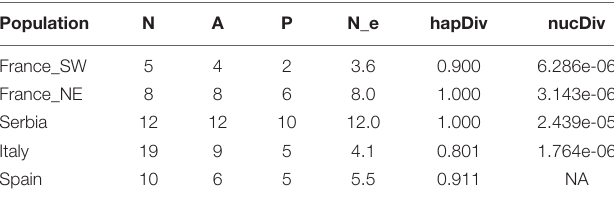
TABLE 2 | Sample size in each population (N), number of haplotypes detected in each population (A), number of private haplotypes (P), effective number of haplotypes (N_e), and genetic diversity suggested by Nei (1987) corrected for sample size (hapDiv) and nucleotide diversity (nucDiv) in chloroplast DNA sequences of Ulmus laevis